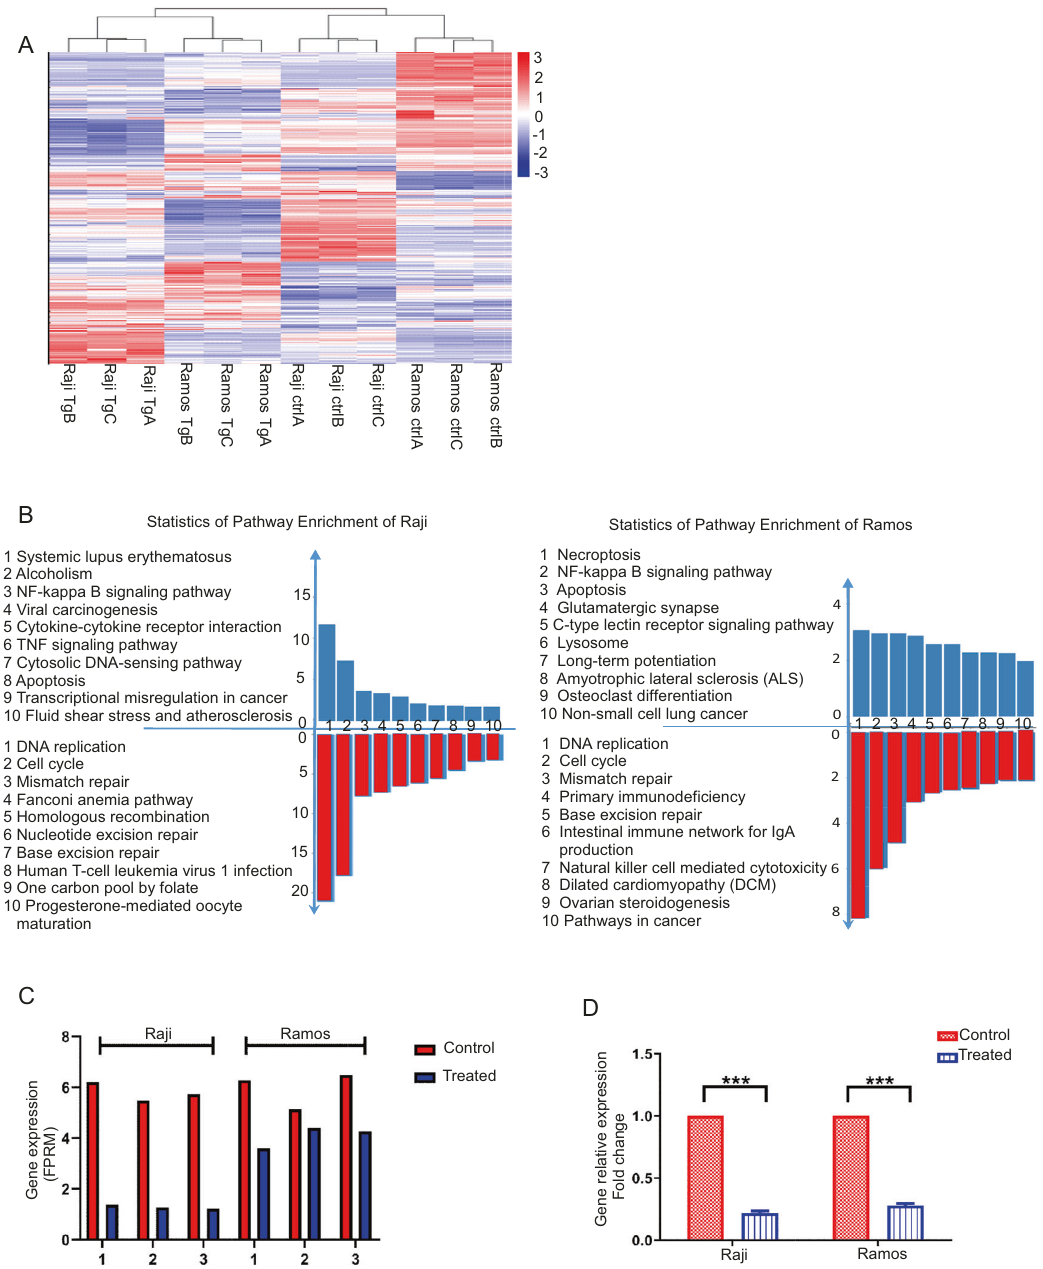
Fig. 4 The antilymphoma effect of TG101209 is involved in the JAK2/STAT3/c-Myb-mediated signaling pathway. A Hierarchical clustering heatmap of differentially expressed genes between control cells and TG101209-treated cells ( n = 3). B KEGG enrichment analysis of the genes of Raji and Ramos cells between the control group and TG101209-treatment group. Functional enrichment analysis was conducted with the Kyoto Encyclopedia of Genes and Genomes (KEGG) database. C Expression levels of c-myb in each sample for RNA sequencing. D c-myb gene expression was signi fi cantly downregulated in TG101209-treated cells compared with control cells, as revealed by RT-qPCR. The data represent the mean ± SEM of three different experiments. *** p < 0.001 (Student ’ s t -test). FPKM = Fragments per gene per kilobase exon per million mapped apoptosis of tumor cells, inhibiting angiogenesis and metastasis. However, very few studies have been conducted to evaluate the ef fi cacy of JAK2 inhibitors in anti-Burkitt lymphoma and inducing the lymphoma cells differentiation. Considering that TG101209 is a small molecular kinase inhibitor, its antilymphoma activity is not only dependent on the cytotoxic effect of the drug but may also be involved in promoting differentiation. We wanted to determine whether TG101209 has pro-differentiation potential in BL cells.